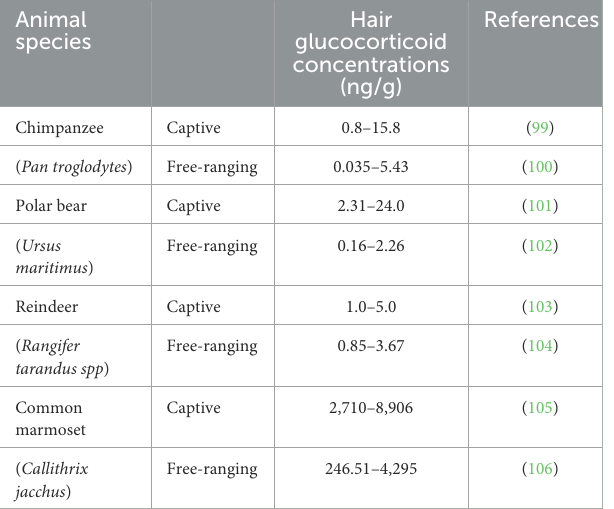
TABLE 4 Hair glucocorticoid concentration in some captive and free-ranging species. Animal species